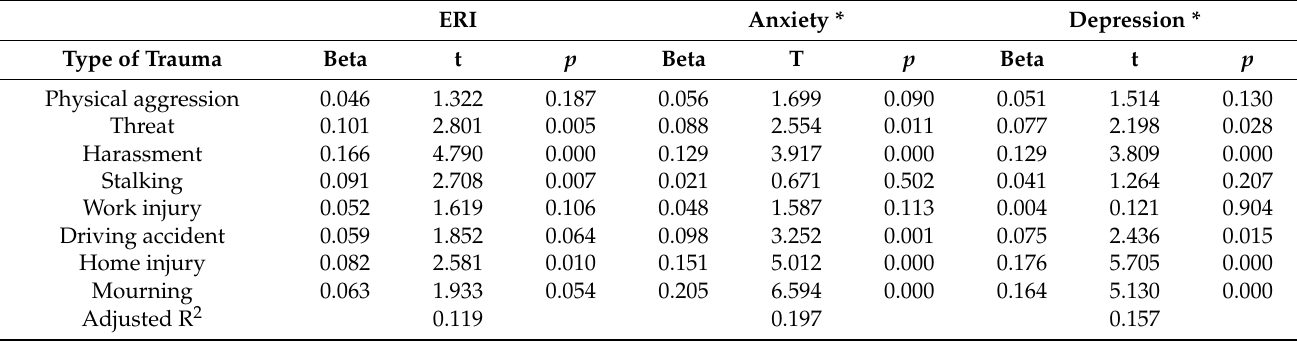
Table 3. Association of traumatic events with occupational stress (ERI), anxiety, and depression. Multiple linear regression models adjusted for age and